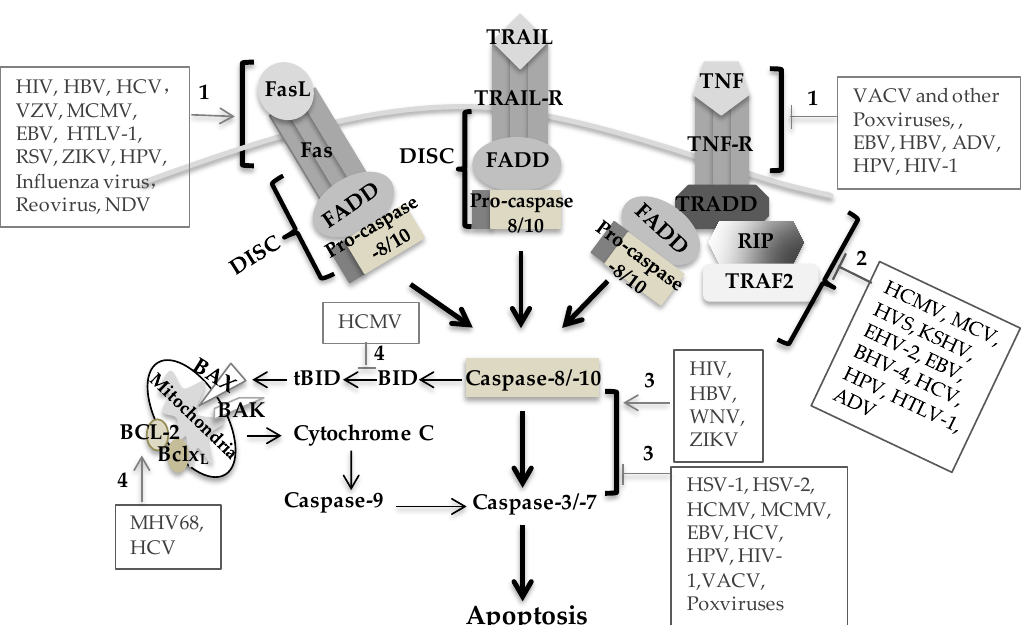
Figure 1. Viral modulation of death-receptor mediated apoptosis. Death receptors Fas, TRAIL-R and TNF-R form DISC upon binding to their ligands, activate caspase cascade and subsequently initiate extrinsic apoptosis. Caspase-8 activation can cleavage BID to tBID and link to mitochondria-mediated intrinsic apoptosis pathway. Virus infection regulates death receptor-mediated extrinsic apoptosis mainly through virally encoded proteins. The regulatory mechanisms involve: (1) regulating the expression and function of death receptors/ligands; (2) interfering DISC formation and function; (3) regulating caspase activities; (4) regulating the expression and function of pro-apoptotic and anti-apoptotic proteins. Black arrow represents signal induction; grey arrow represents signal induced by viruses; grey T bar represents signal inhibited by viruses.